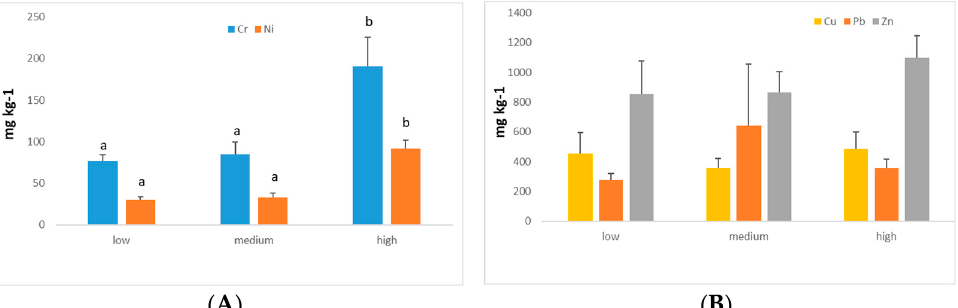
Figure 3. ( A ) Cr and Ni concentrations as a function of traffic density (low, medium, and high). Different lowercase letters indicate a significance difference among levels of traffic density for specific heavy metals (Tukey, p = 0.002 for Cr, and Tukey p = 0.03 for Ni). ( B ) Cu, Pb, and Zn concentrations as a function of traffic density (low, medium, and high). No statistical significance between different traffic densities for any of the heavy metals shown.